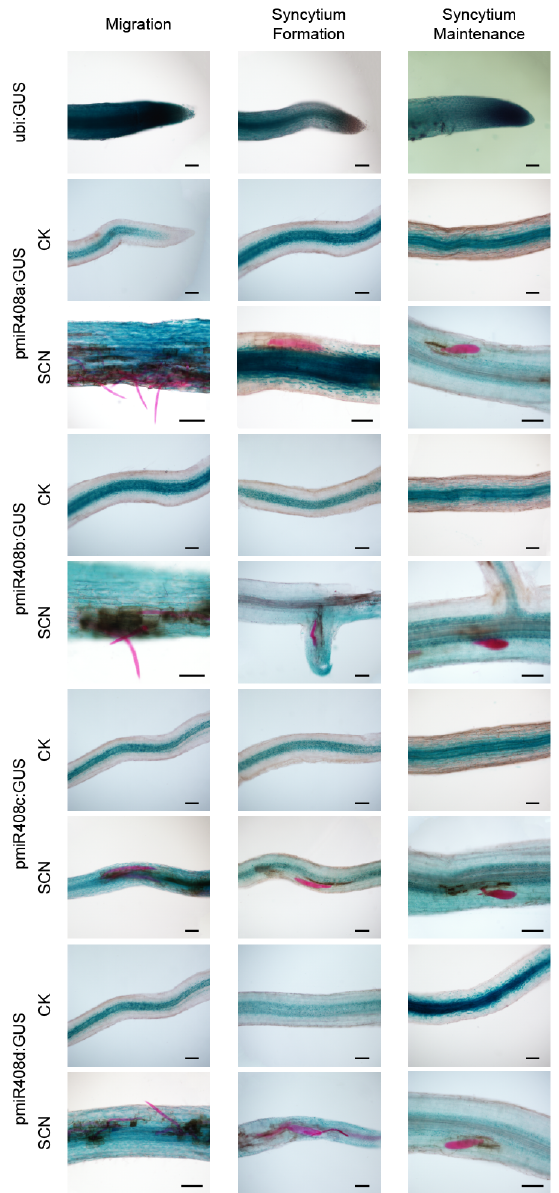
Figure 4. Histochemical staining of GUS activity driven by miR408 promoters in transgenic soybean in response to H. glycine infection. Soybean cyst nematode infected Williams 82 plants were named W82+SCN, the non-infected were W82+CK. Use ubi :GUS as a positive control. The miR408 promoter sequence after adding base arms was inserted into the linearized pNINC2GUS and obtained the GUS vector pmiR408 :GUS. GUS activity of the pmiR408 :GUS plants under non-infected conditions only showed in the vascular tissue of roots. While the whole root showed GUS activity response to nematode infection. GUS reactivity gradually weakens with the stage of nematode infestation. Bars = 100